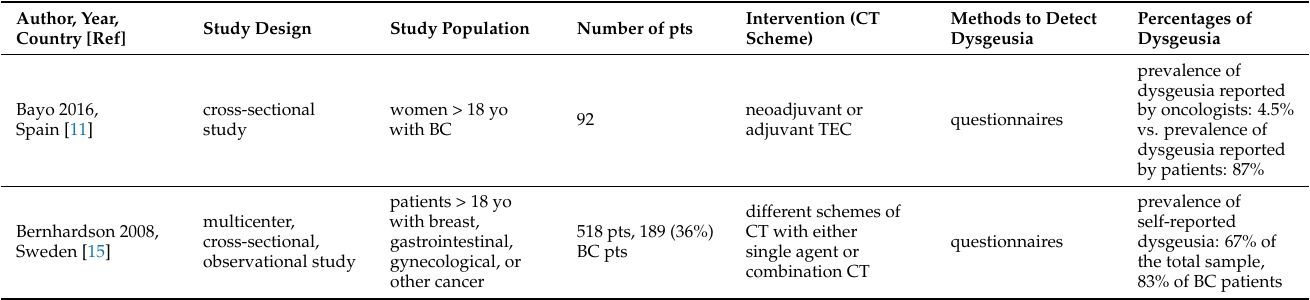
Table 1. Characteristics of the studies assessing the occurrence of CT-related